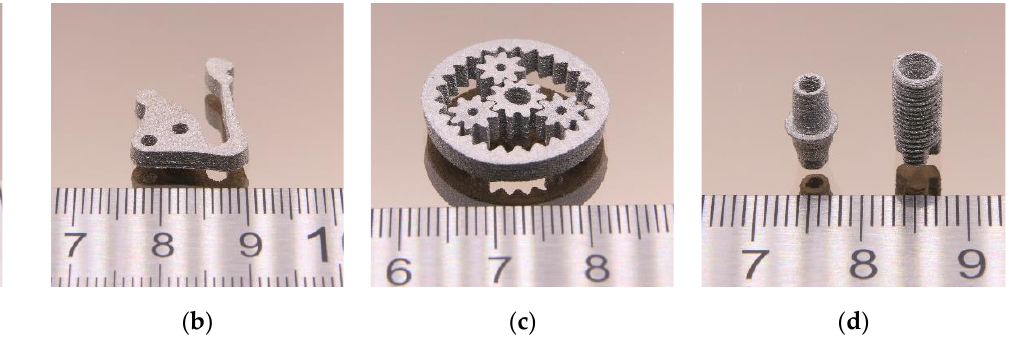
Figure 17. Sintered Ti6Al4V parts (initial solid load: 60 vol%. ( a ) Puzzle (binder PEG/PMMA); ( b ) test structure with long cantilever and holes (binder PEG/PMMA); ( c ) planetary gear train (binder PEG/PVB); ( d ) dental implants (binder PEG/PVB).